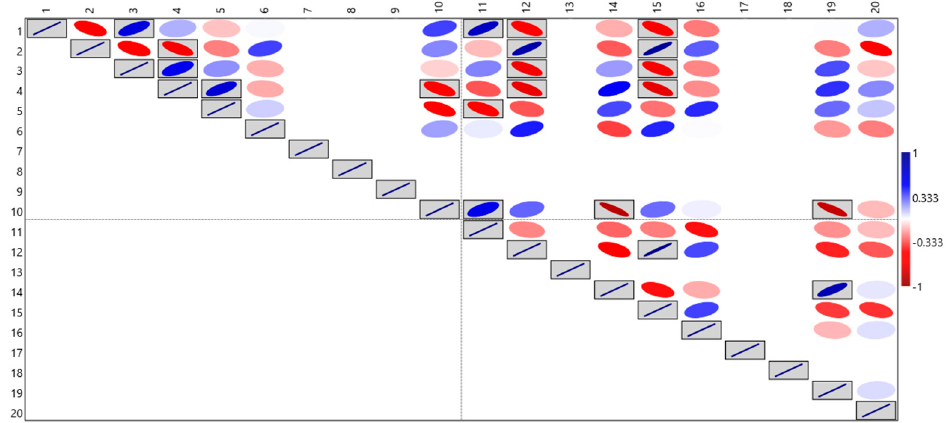
Figure 2. Pearson correlation among the bioactive compounds of V. calcarata subsp. calcarata white (CW), V. calcarata subsp. calcarata yellow (CY), V. calcarata subsp. calcarata violet (CV), and V. calcarata subsp. villarsiana (VB), calculated and drawn using PAST 4.03 software. Boxed ellipses are significantly correlated ( p < 0.05). Blue indicates a positive correlation and red indicates a negative correlation. The more the ellipse is compressed, the stronger the correlation. 1. phenolic compounds; 2. anthocyanins; 3. FRAP; 4. DPPH; 5. ABTS; 6. dry matter; 7. caffeic acid; 8. chlorogenic acid; 9. coumaric acid; 10. ferulic acid; 11. hyperoside; 12. isoquercitrin; 13. quercetin; 14. quercitrin; 15. rutin; 16. ellagic acid; 17. gallic acid; 18. catechin; 19. epicatechin; 20. vitamin C.